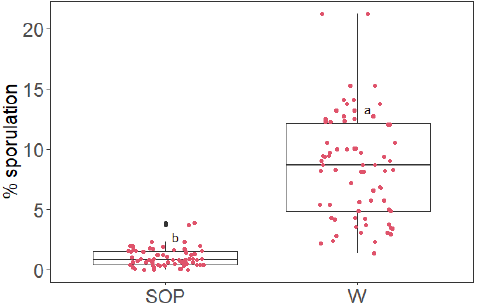
Figure 4. Boxplot of the percent ratio between the sporulating area and the total disc area (% sporulation) on grapevine leaf discs treated with Salvia officinalis phytocomplex solution 5 g/L (SOP) or deionized water (W) and inoculated 5 days later with P. viticola sporangia. Data from three repetitions of the experiment were analyzed together. Different letters indicate significant differences between mean log (%sporulation + 1) based on multiple comparisons analysis with Bonferroni correction (level of significance = 0.05). Raw data values are overlaid to the boxplot as red dots, with added horizontal jitter for